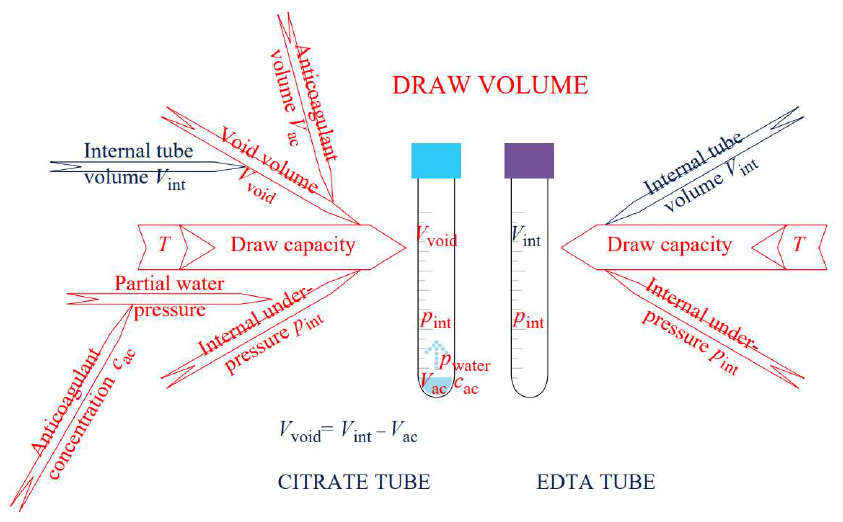
Figure 5. Parameters influencing a draw volume in the citrate ( left ) and EDTA ( right ) blood collection tubes, parameters that vary are indicated in red.